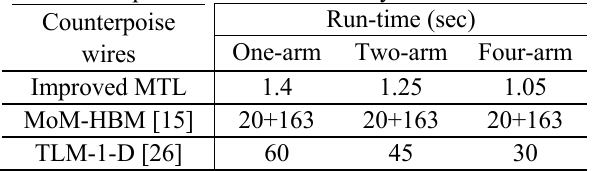
Figure 15: Variation of DF versus for counterpoise wires.